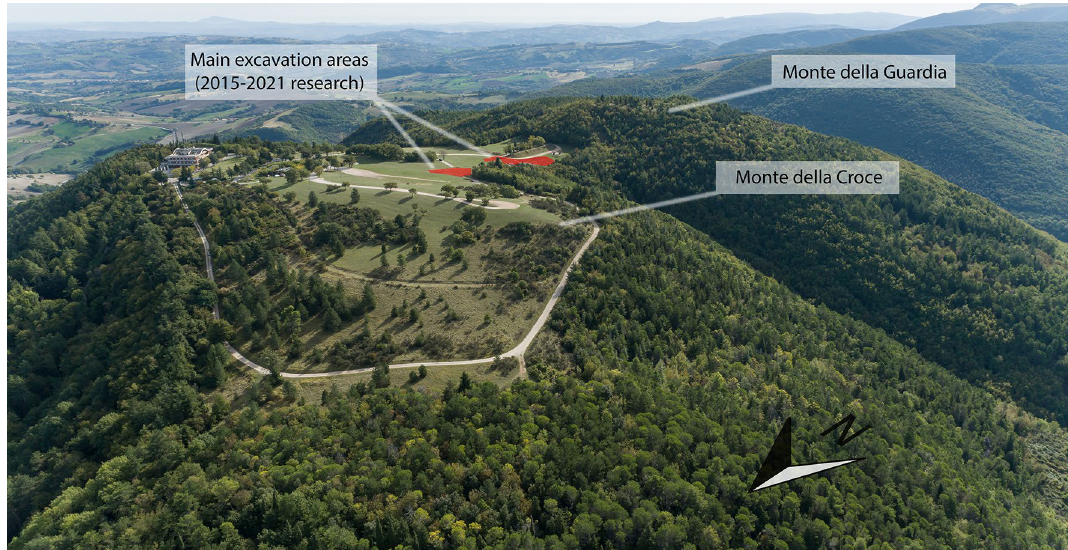
Figure 1. Drone aerial view of the Monte Croce Guardia archaeological site, with the indication of the main research areas of the 2015–2021 campaigns (photo by A.